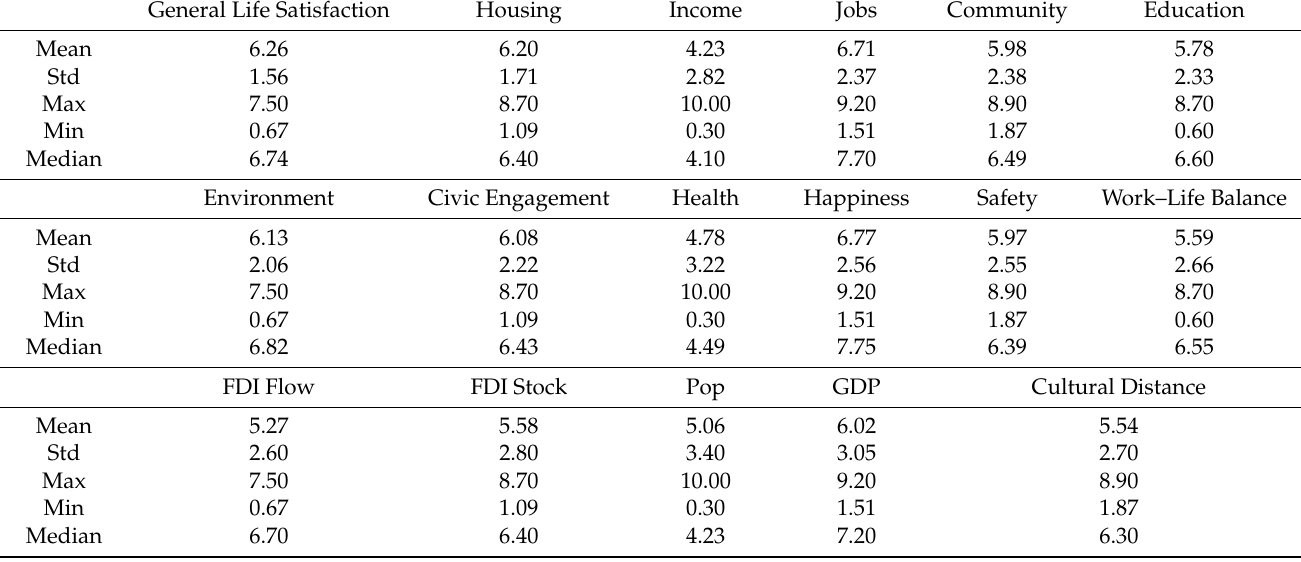
Table 2. Descriptive analysis of wellbeing in OECD countries for Chinese outward